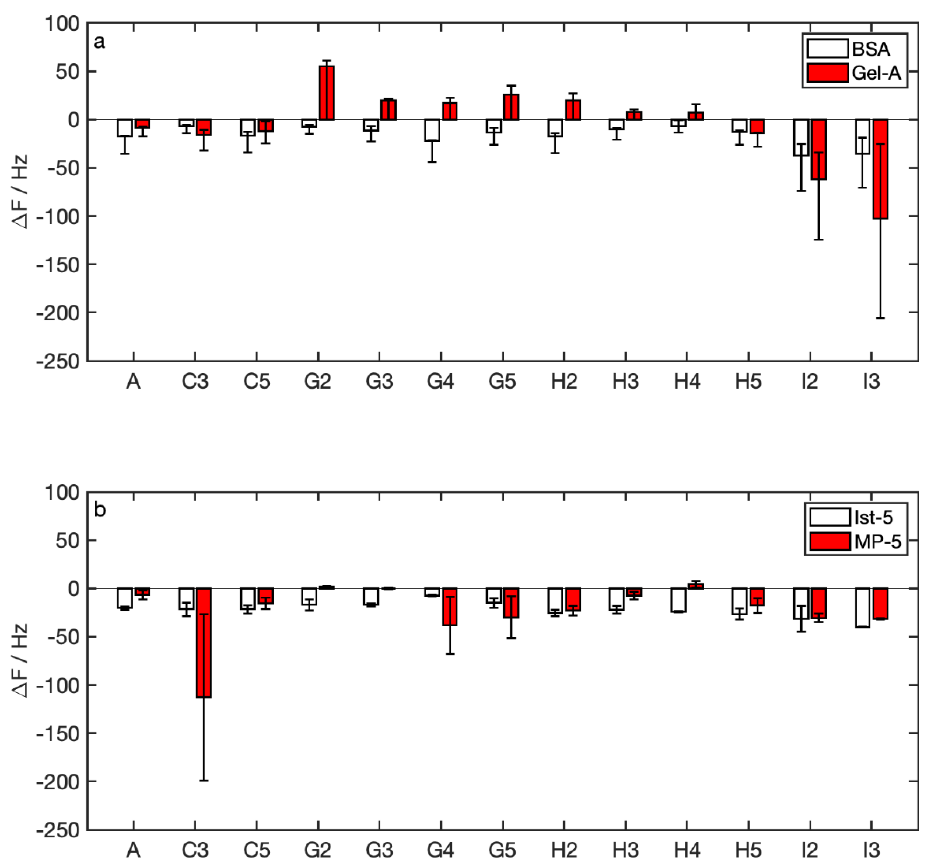
Figure 6. Detection of polyphenols in winery solutions: ∆ f vs. sample nomenclature in ( a ) proteins, ( b ) peptides. ∆ f values measured for samples G and H were aggregated and plotted against the measured polyphenol concentration (Folin–Ciocalteu method) and pH (Figure 7). We found high correlations between values obtained with Gel-A vs. polyphenol concentration and between values obtained with BSA and pH.